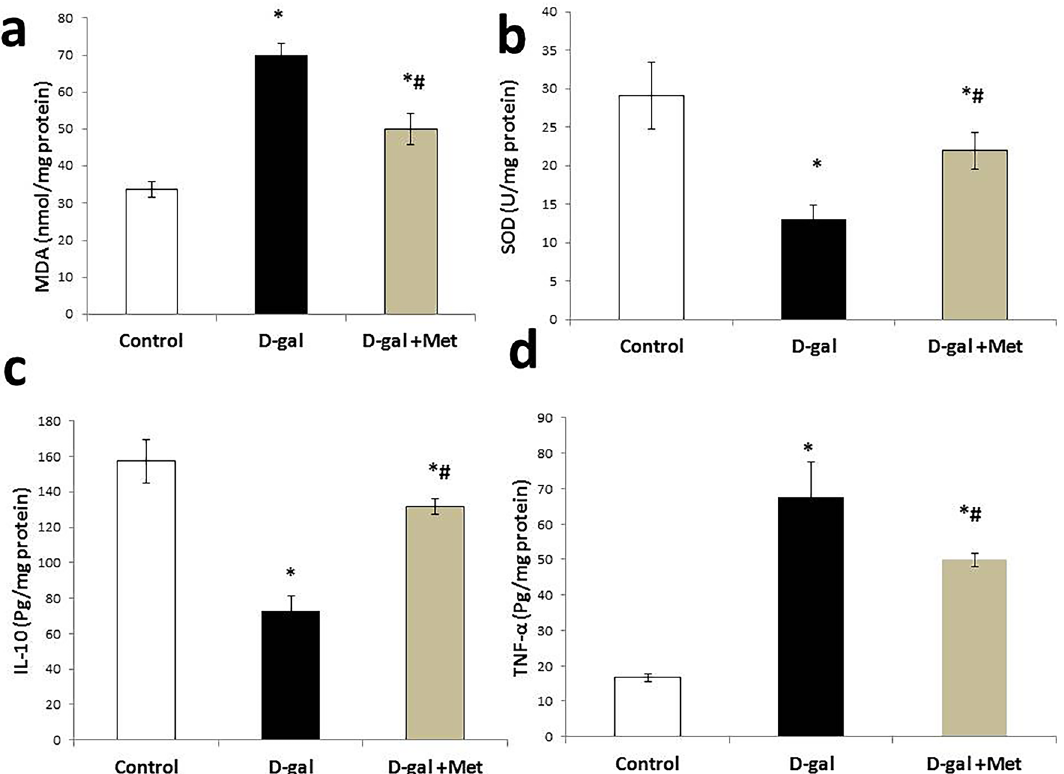
Figure 4. Metformin ameliorates the oxidative stress and inflammatory status in D-galactose-induced aging rat model (*significant when compared to control group, # significant when compared to D-gal group). Data are shown as means + SD (n = 10). ANOVA was used to make group comparisons; Significance = P < 0.05).